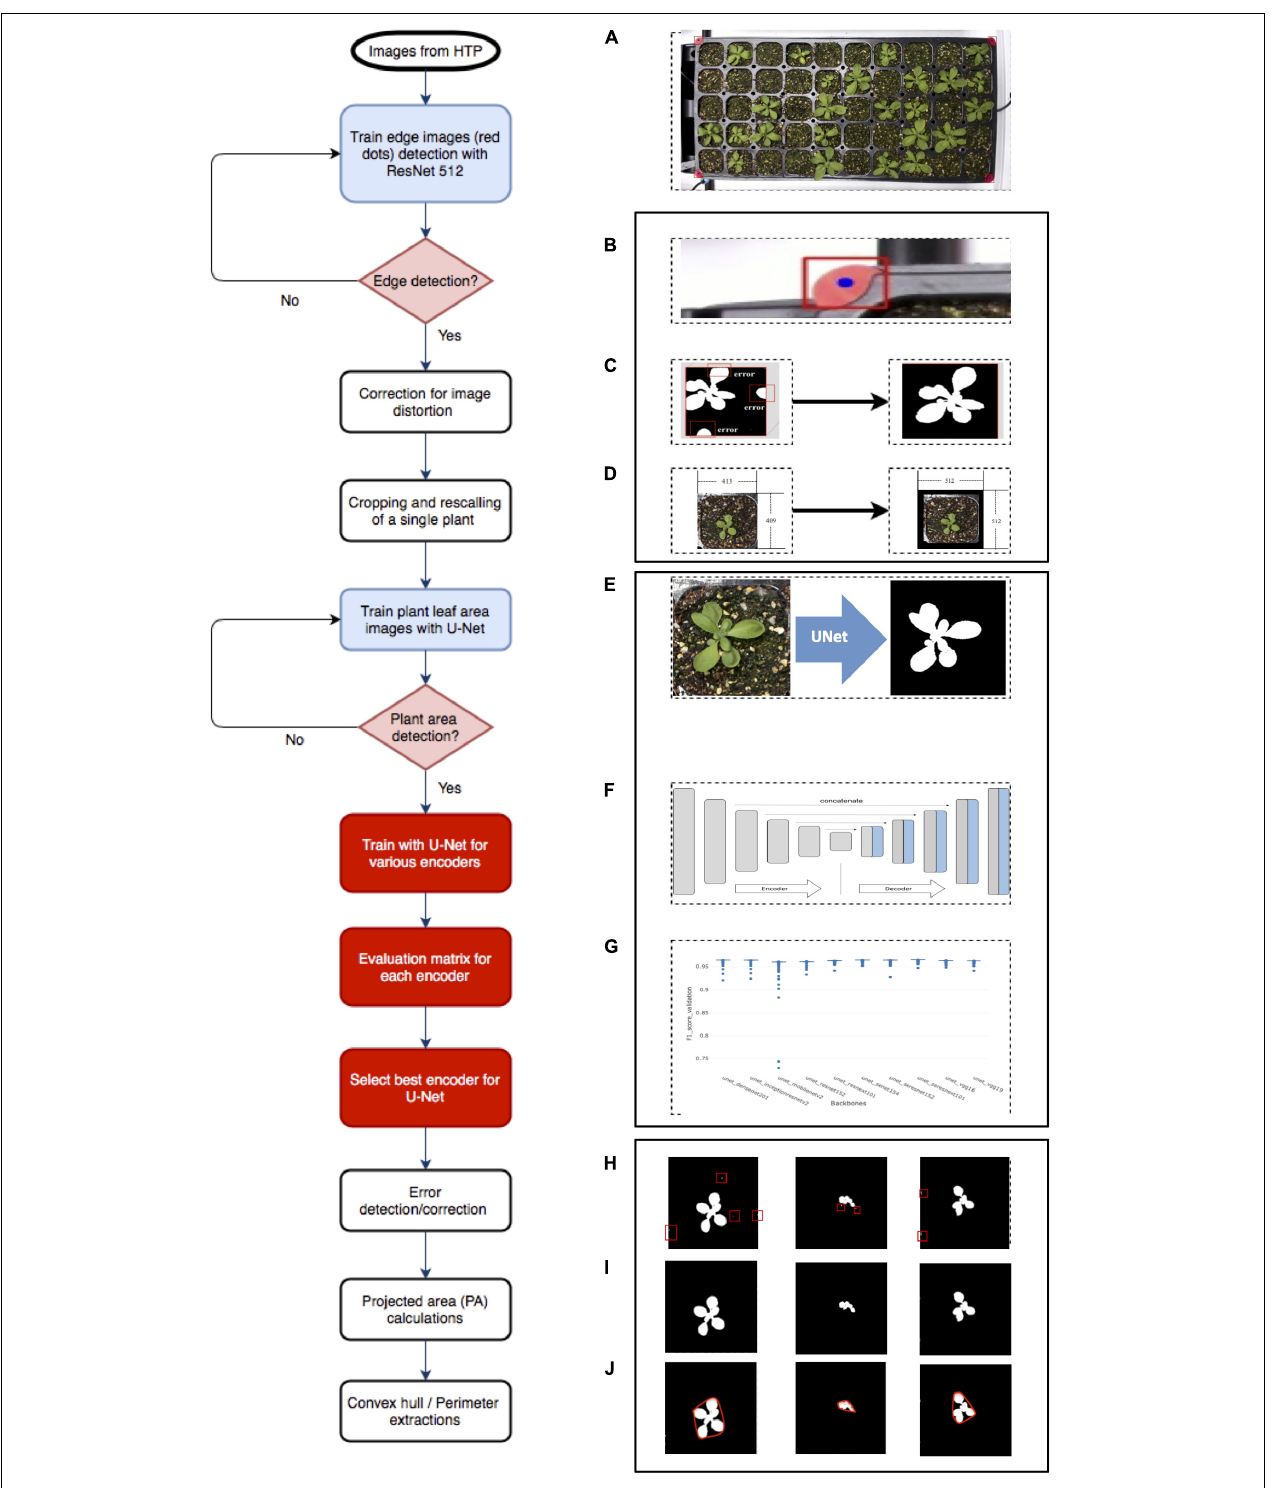
FIGURE 1 | Overview of Arabidopsis image analysis pipeline. There are three steps for image analysis. The first step is the preprocessing of raw images by (A) the acquisition of the raw image, (B) detecting reference point (red dot), (C) correcting images with the red dot, (D) cropping into single plant images, and rescaling. The second step is to train the (E) U-Net with various encoders and selecting encoders for the best result using the U-Net structure, (F) including encoder section, training network with various encoders, such as SE-RENext101, (G) comparing results from various encoders. The last step is the post-processing of images and exporting data using (H) error detection with a conditional random feature, (I) extract PA, and convex hull area, (J) perimeter.